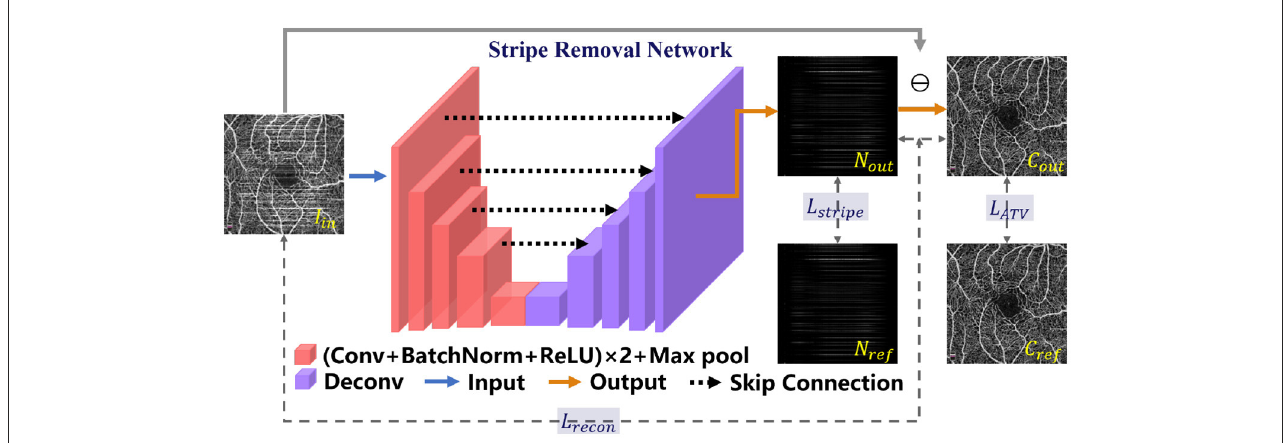
FIGURE3 Illustration of the Stripe Removal Net (SR-Net) for the de-striping stage. The proposed objective function L destripe is a combination of L recon , L stripe and L ATV